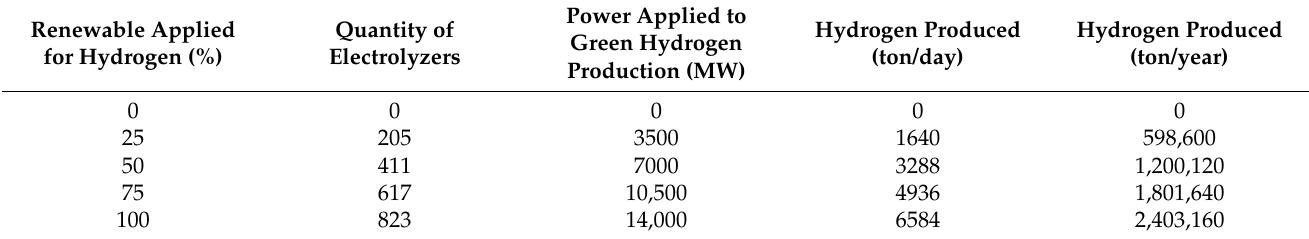
Table 8. Quantity of electrolyzers and production of